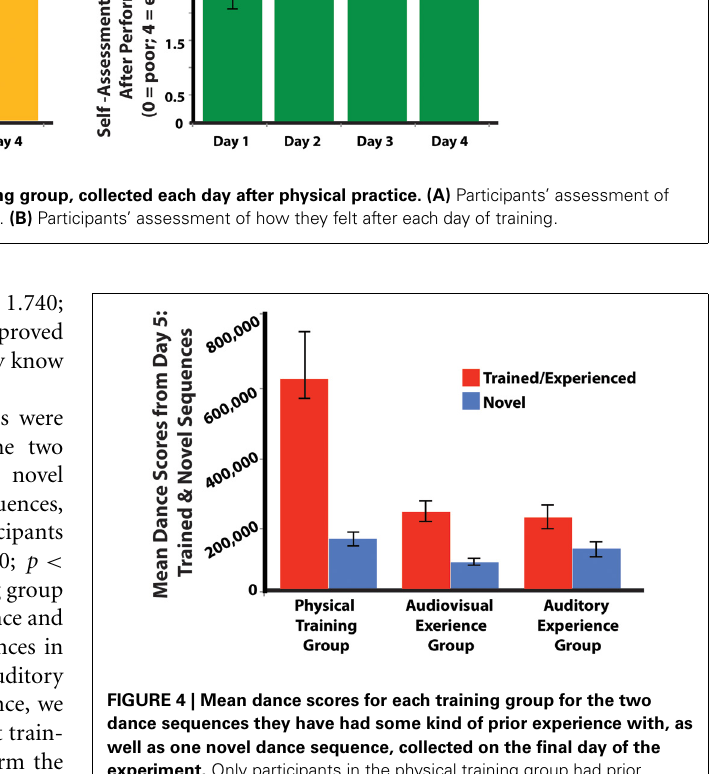
FIGURE 4 | Mean dance scores for each training group for the two dance sequences they have had some kind of prior experience with, as well as one novel dance sequence, collected on the final day of the experiment. Only participants in the physical training group had prior experience with dancing any of the